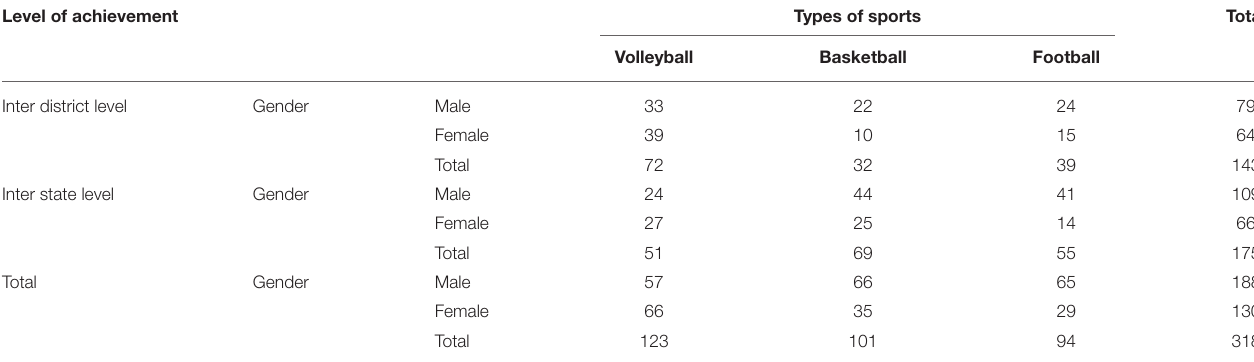
TABLE 1 | Demographic